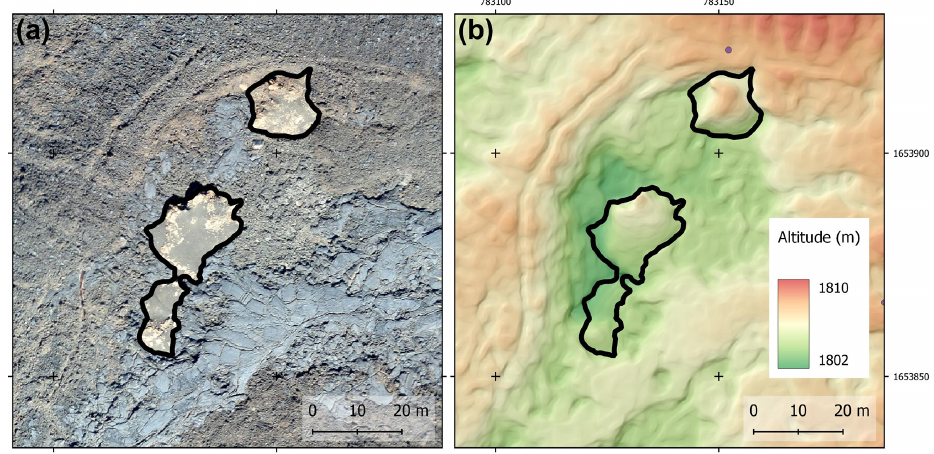
Figure 18. Example of k¯ıpukas (islands of pre-eruption material surrounded by lava) that have been identified in the present lava delineation, influencing the area estimates when compared to work from other authors. (a) Orthomosaic and (b) hill shade model over the